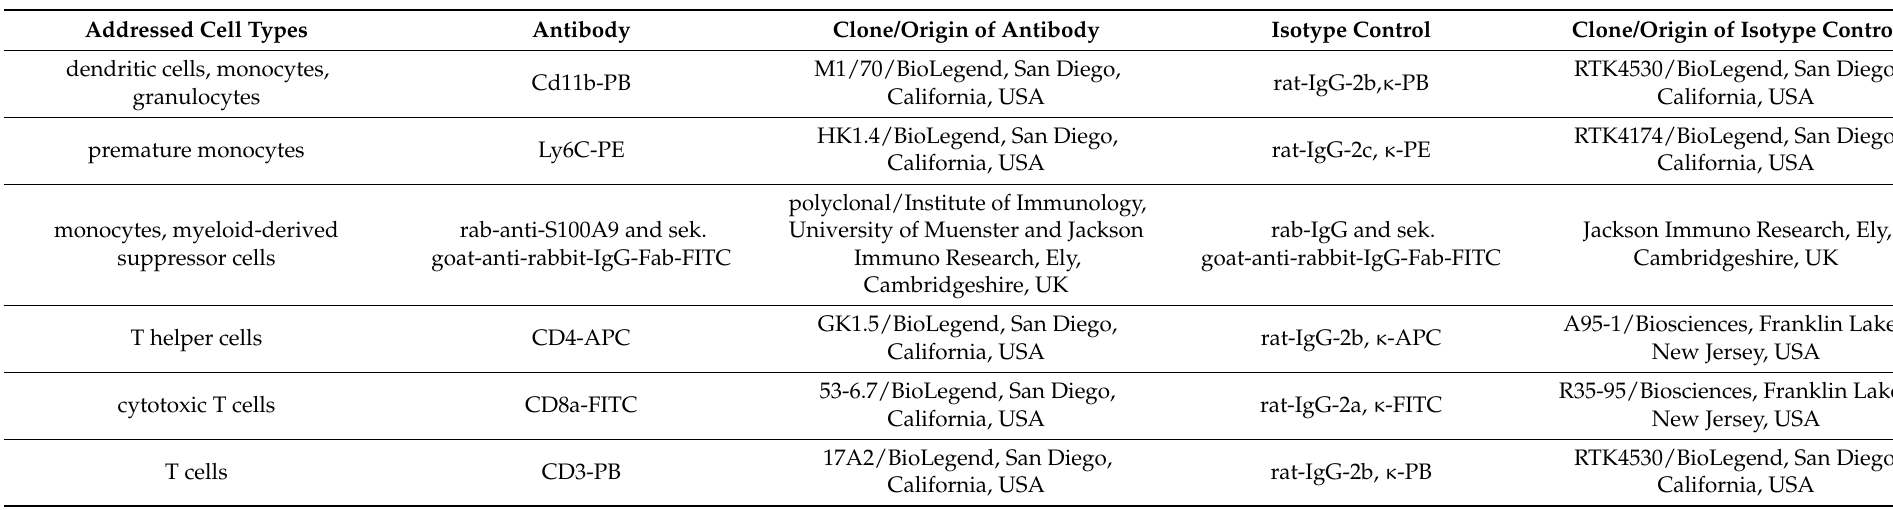
Table 1. Flow cytometry staining strategy for examined antibodies (first column) with corresponding isotype controls (fourth column) and addressed cell types (third column). Addressed Cell